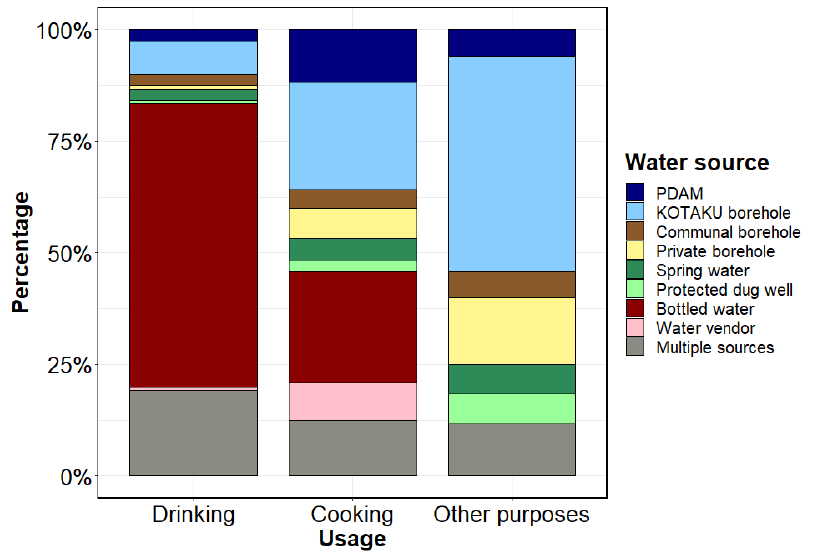
Figure 2. Water source distribution for drinking, cooking, and other purposes selected by households in slum areas, ( n = 120).